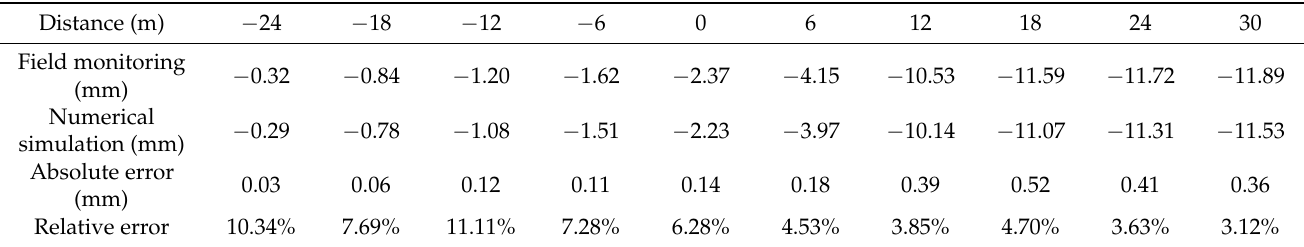
Table 2. Longitudinal surface displacements of A 10 and hole 1 #.